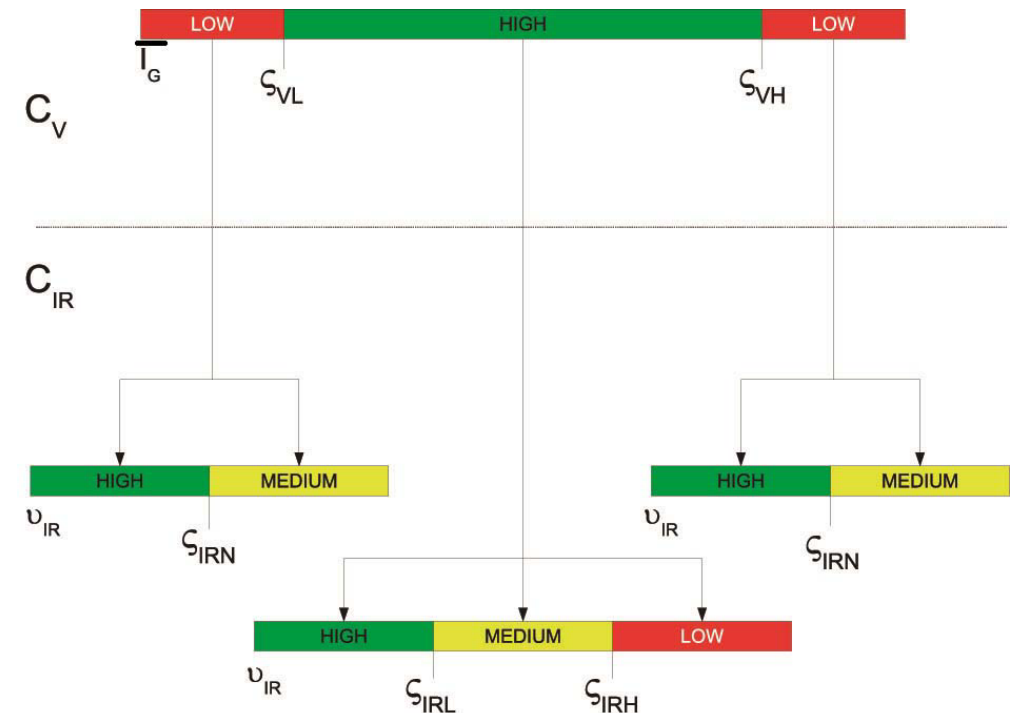
Figure 1. Set up of the confidence